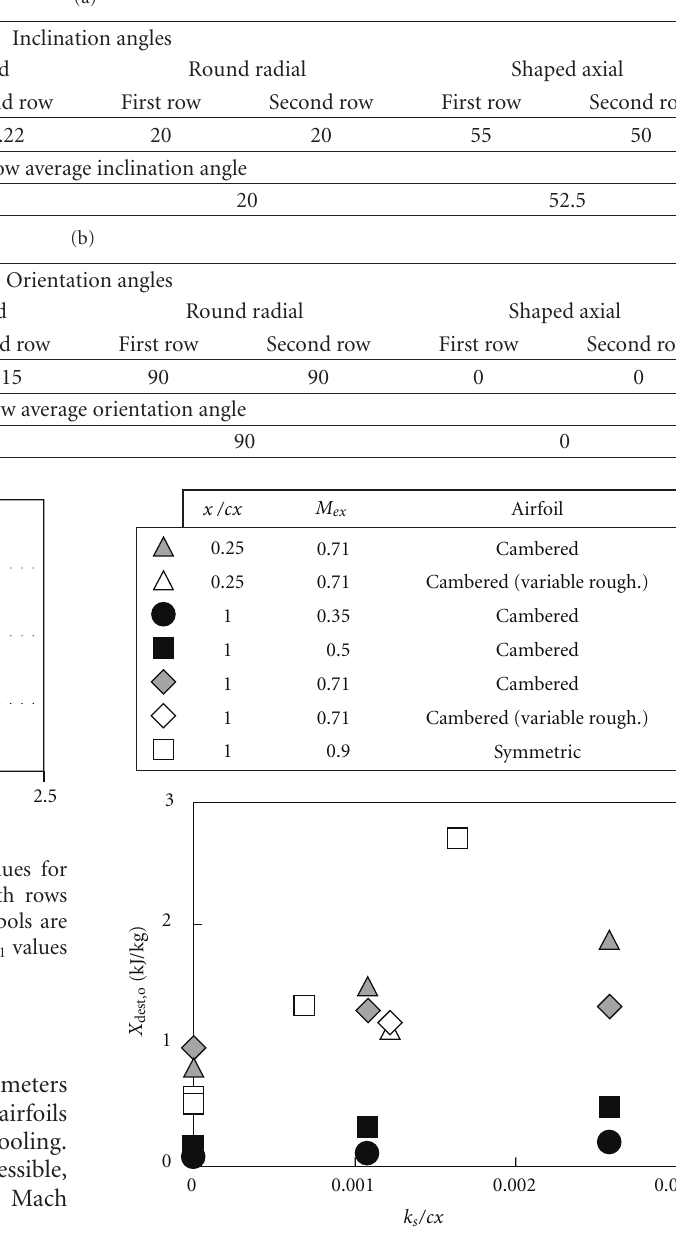
Figure 26: Overall exergy destruction as it varies with surface roughness condition for di ff erent measurement locations down- stream of di ff erent airfoils with di ff erent exit Mach numbers, for freestream turbulence intensity values from 0.9 to 1.5